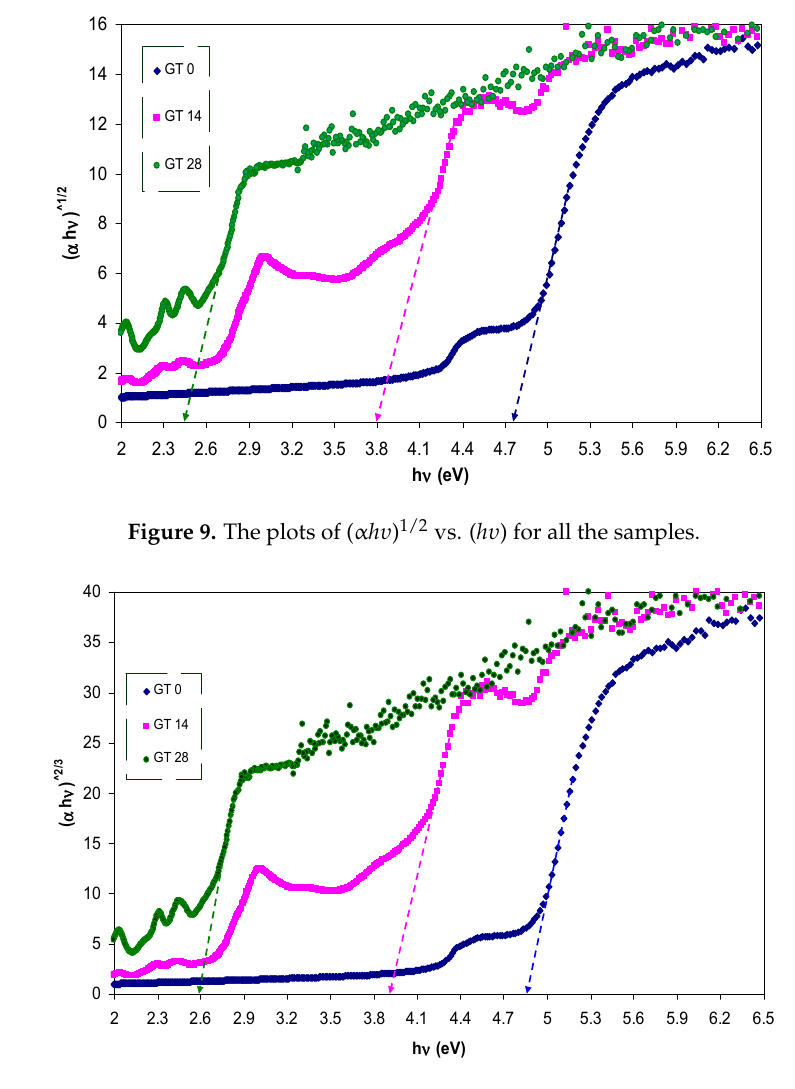
Figure 10. The plots of ( α h υ ) 2/3 vs. ( h υ ) for all the samples.